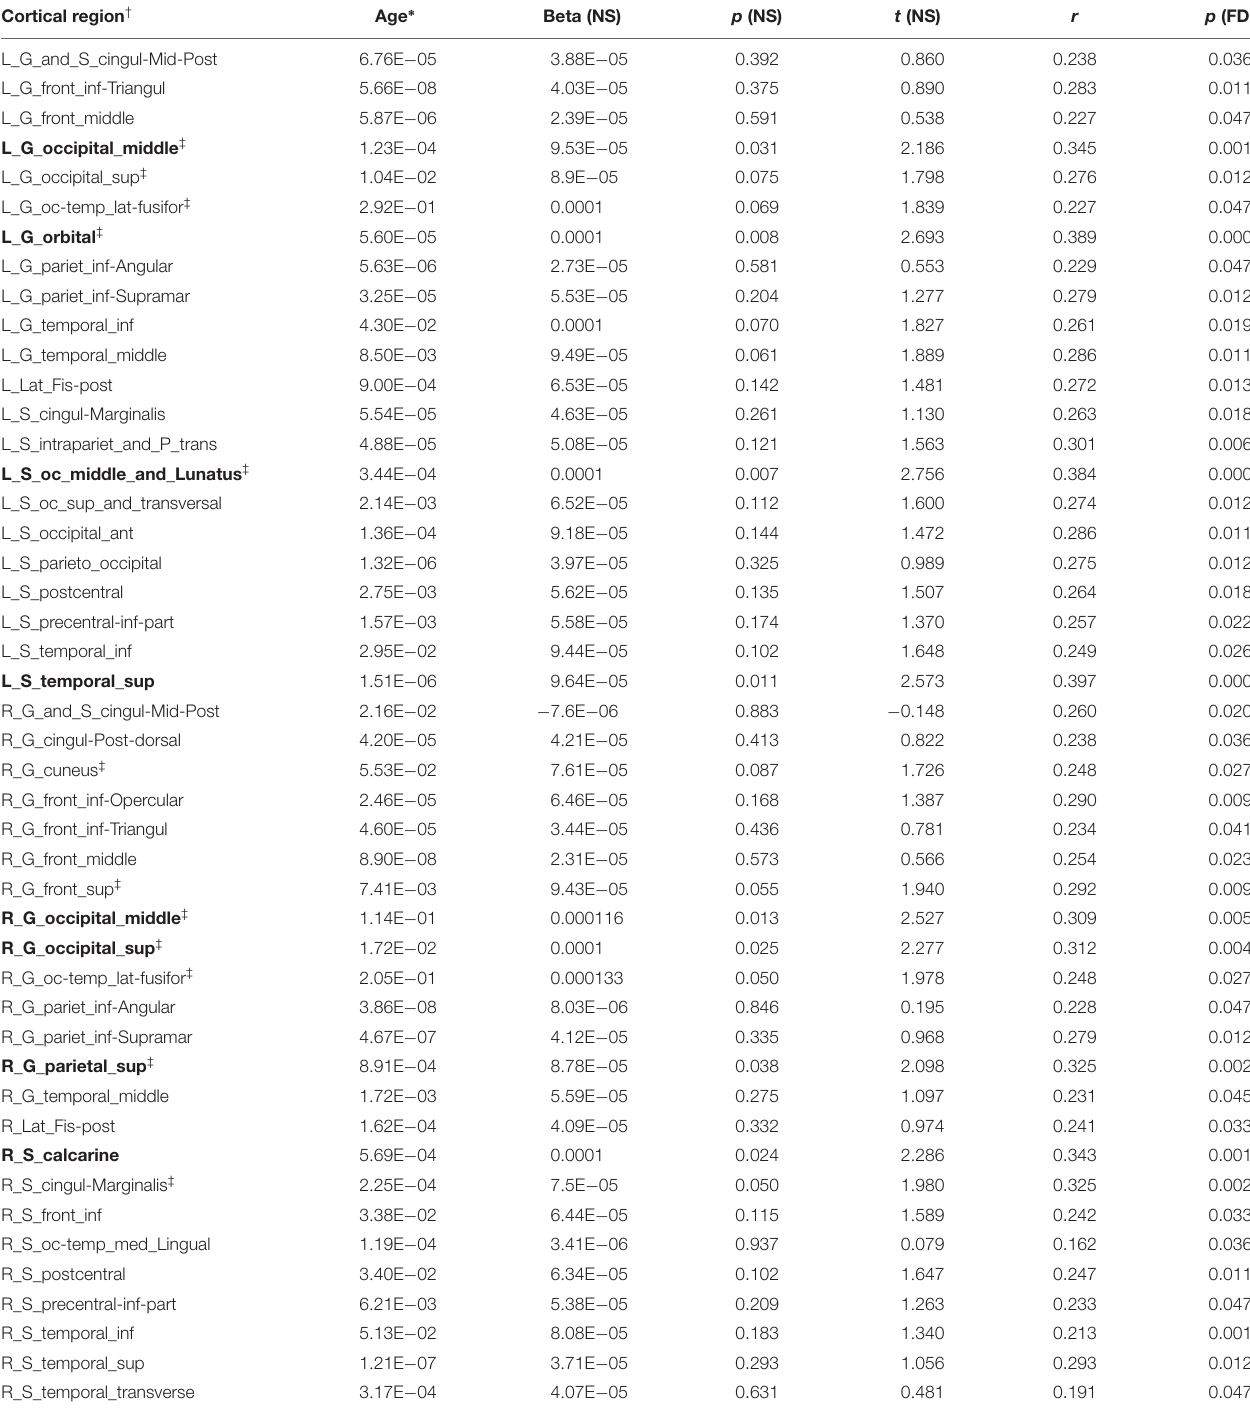
TABLE 4 | Pregnenolone association with cortical